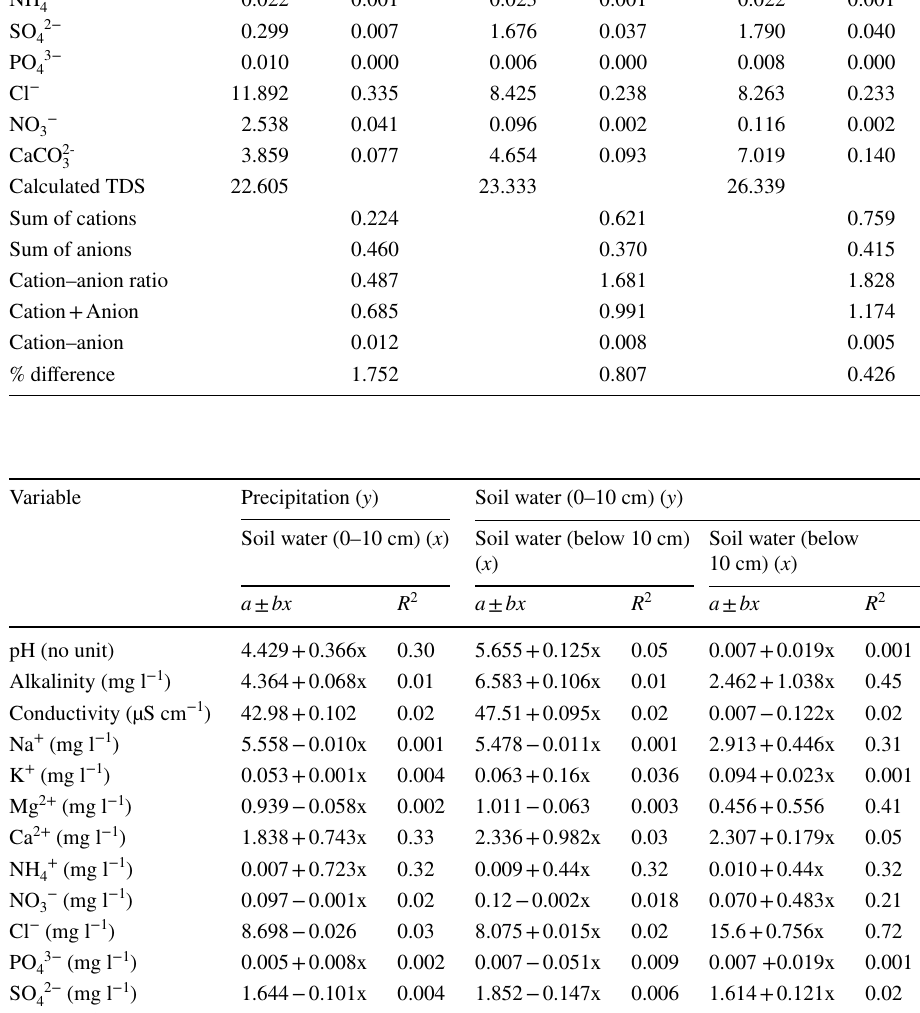
R 2 = Coefficient